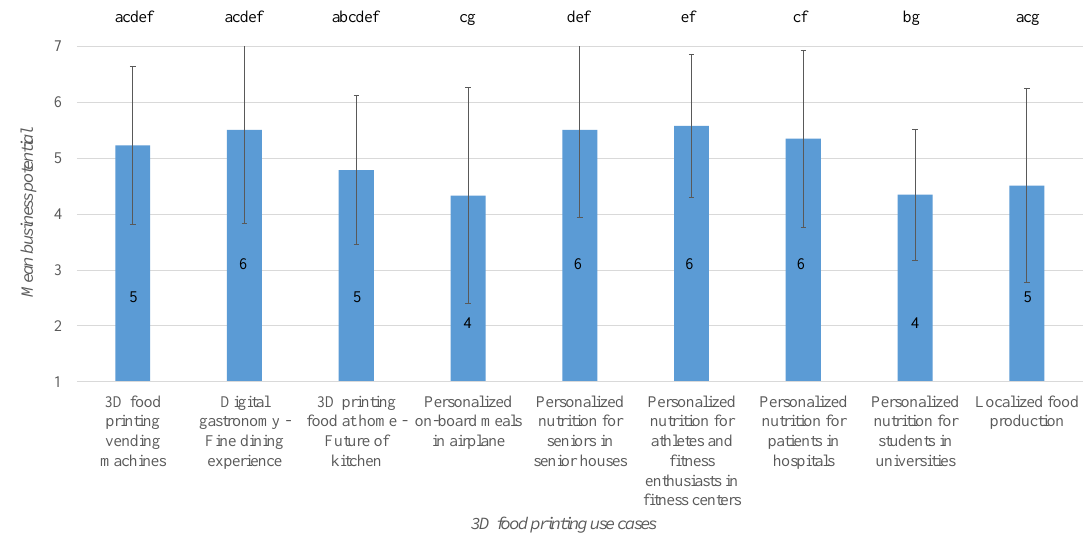
Figure 7. Bar plot of means for business potential of identified 3D food printing use cases. Error indicates the standard deviation, and the number inside the bars indicates median. Bars sharing the same letter are not significantly di ff erent according to Wilcoxon signed rank